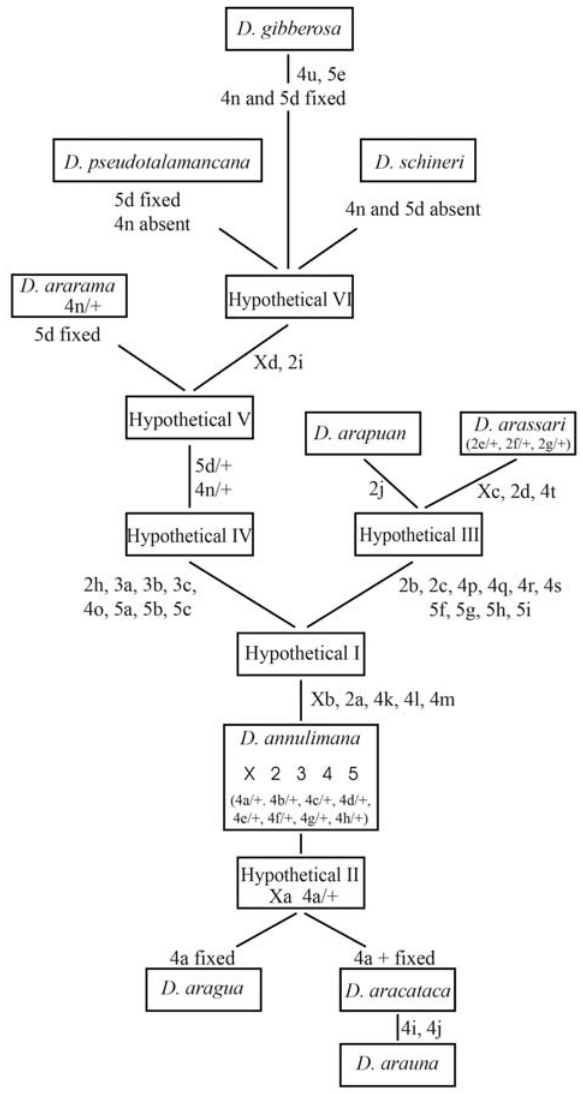
Figure 17 - Phylogenetic relationships among ten Drosophila species of the annulimana group based on paracentric inversions found in the poly- tene chromosomes. The rearrangements named “hypothetical I” through hypothetical “VI” are undetected intermediates steps needed to propose the